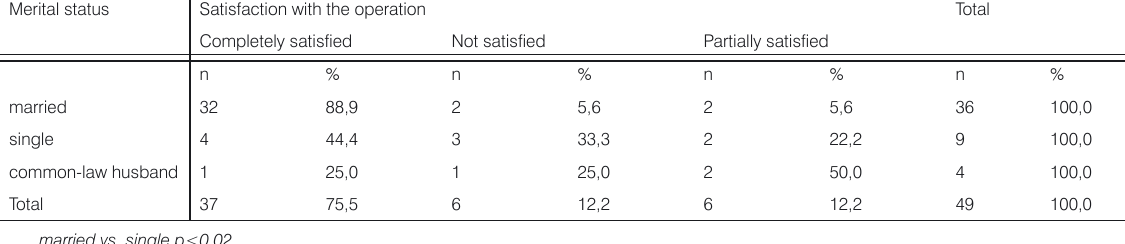
Table 3. Dependency between the merital status and satisfaction with the results of